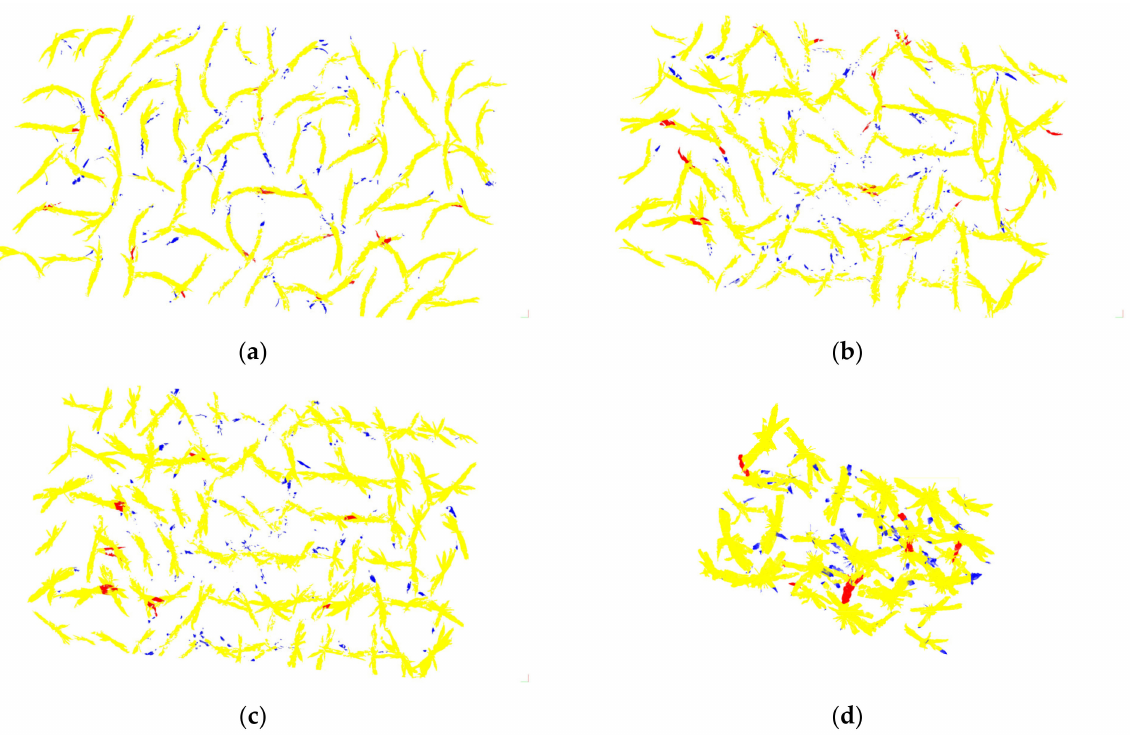
Figure 11. Individual maize plant segmentation. TP renders as yellow point clouds, FN renders as blue point clouds, and FP renders as red point clouds. ( a ) Maize-01 ; ( b ) Maize-02 ; ( c ) Maize-03 ; ( d ) Maize-04